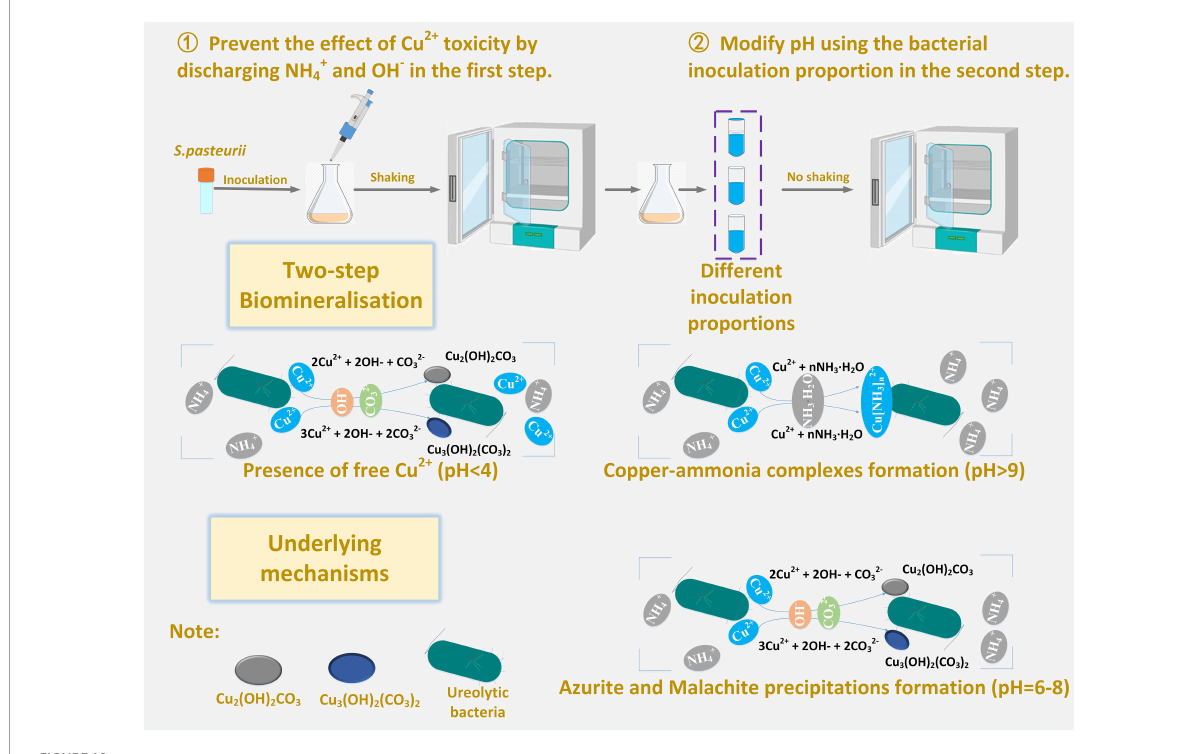
FIGURE10 Schematic illustration of the underlying mechanisms affecting the copper immobilization